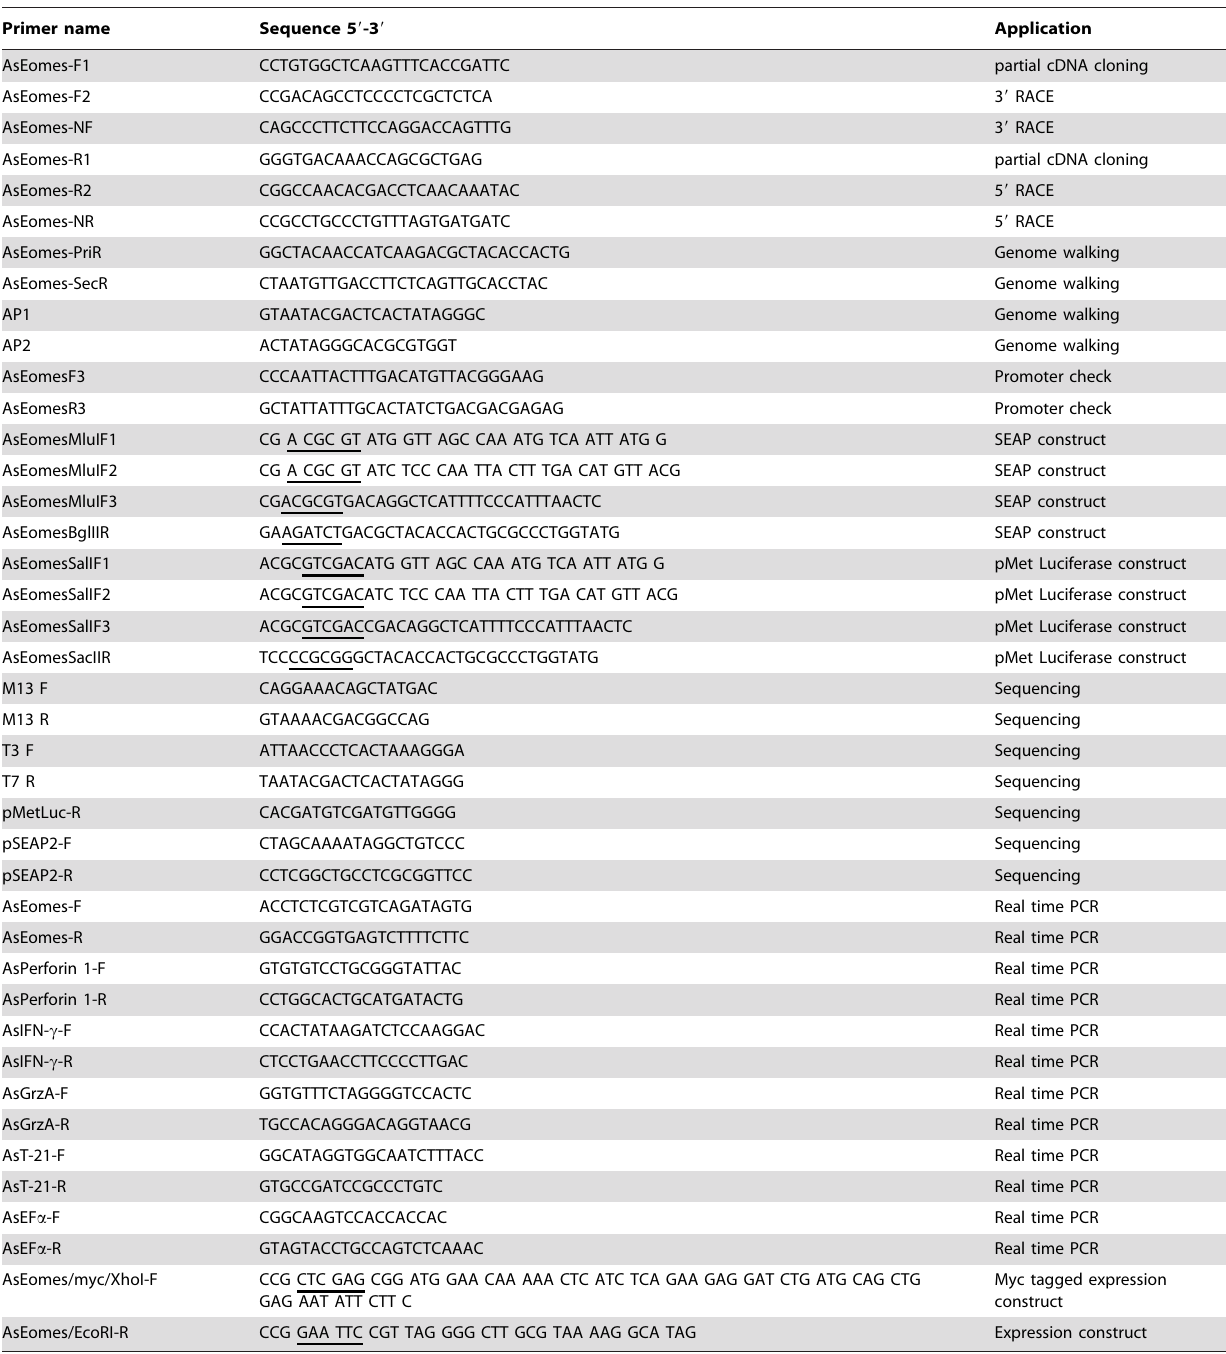
Table 1. List of primers and their designated